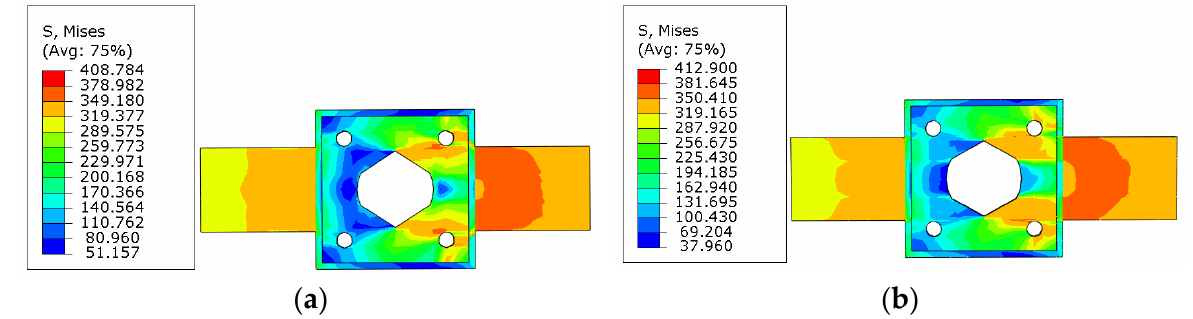
Figure 12. Von Mises stress contours of the end of bottom plate of U-shaped steel beam and the internal diaphragm at the yield state: ( a ) RS connection; ( b ) RT connection.